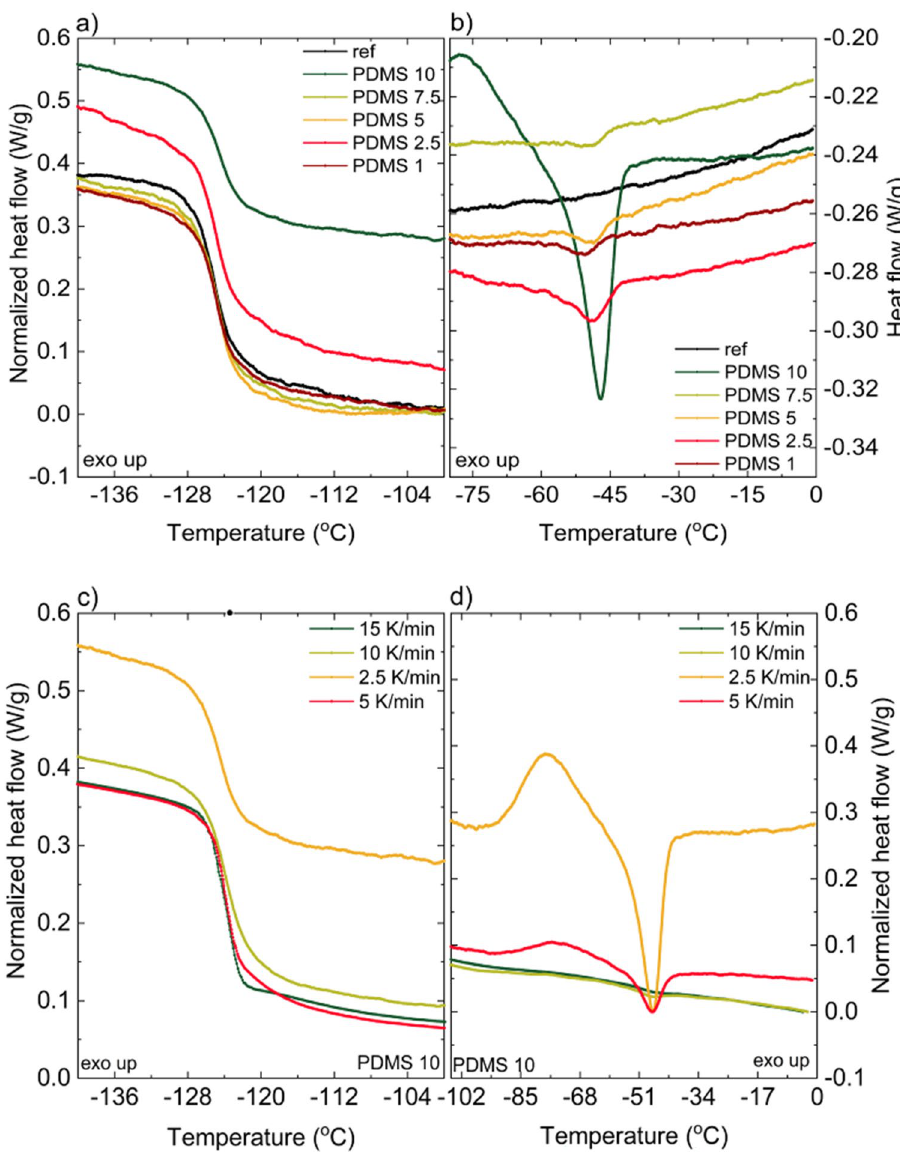
Figure 6. ( a , b ) DSC thermograms of graphene/PDMS nanocomposite of 1–10wt% graphene concentration at the constant heating rate of 2.5°C/min.: the glass transition region ( a ), melting peaks ( b ), ( c , d ) DSC thermograms of 10%wt graphene/PDMS nanocomposite at different heating rates showing glass transition region ( c ) and melting peaks ( d